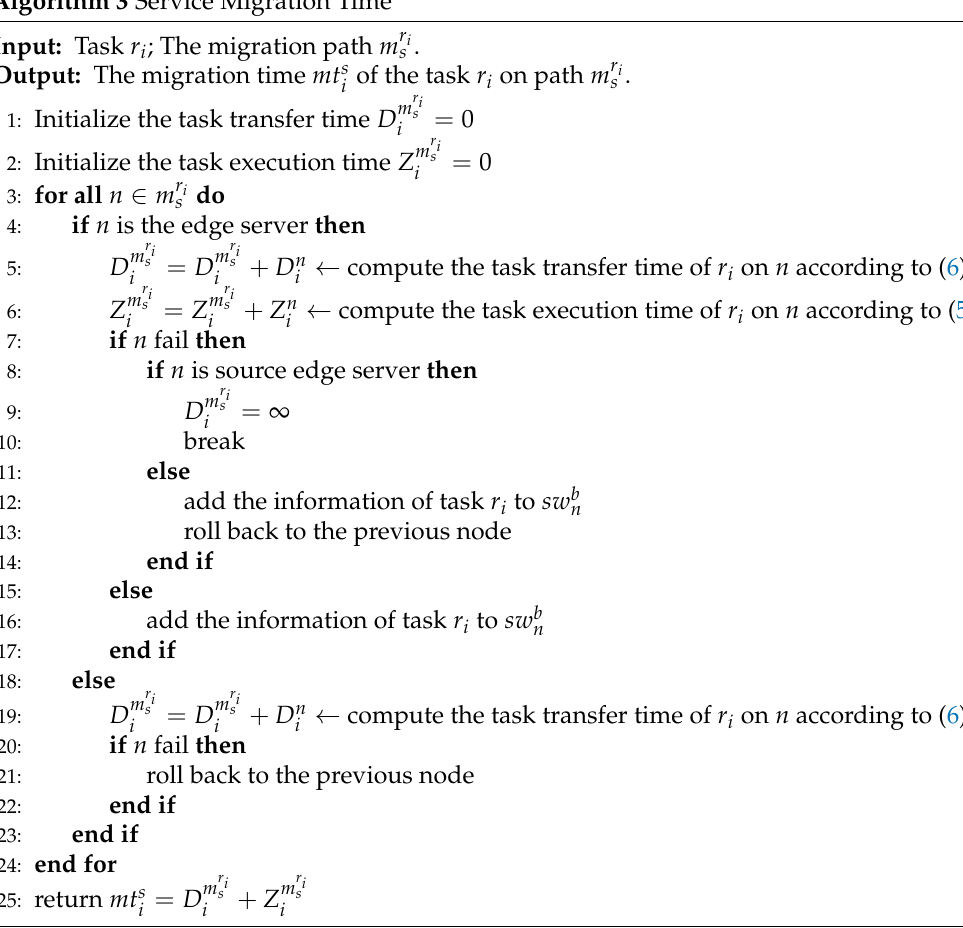
Algorithm 3 Service Migration